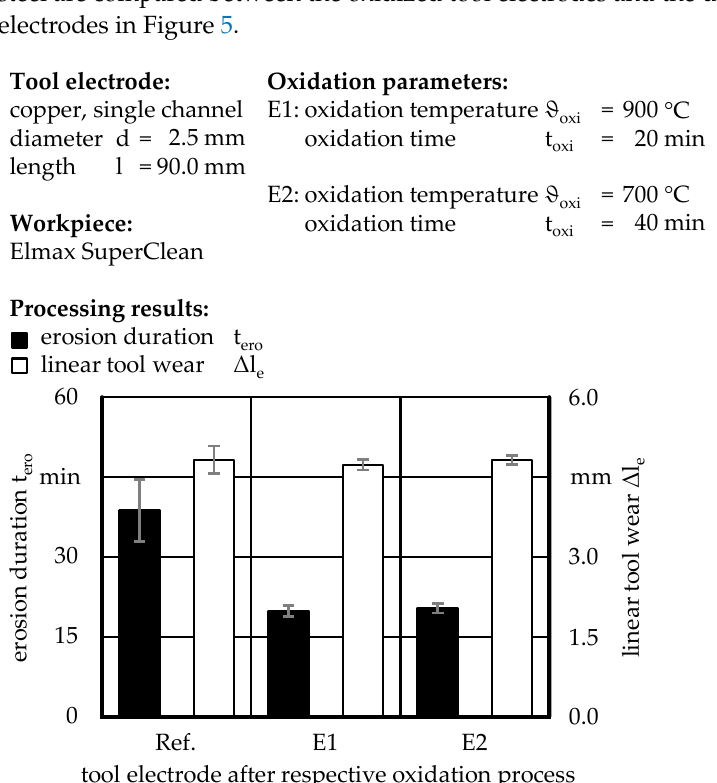
Figure 5. Erosion duration (t ero ) and linear tool wear ( ∆ l e ) for the machining of Elmax SuperClean tool steel.